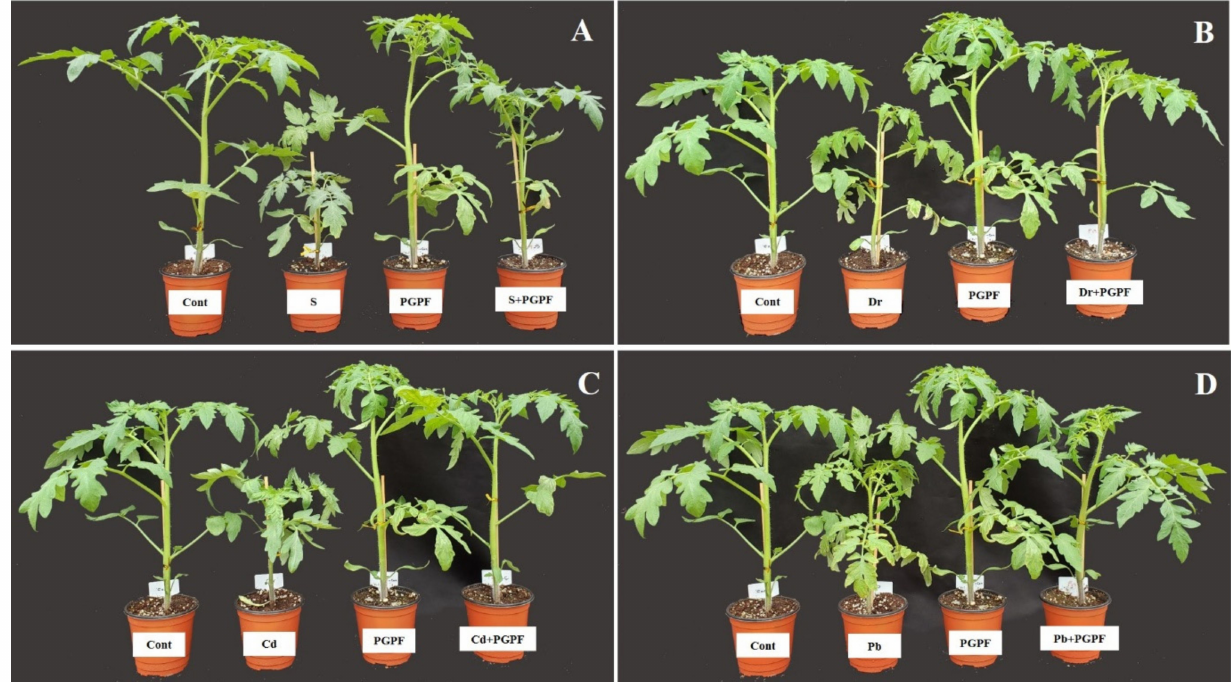
Figure 2. Effects of PGPF inoculation on tomato plant growth under normal and stress conditions after 10 days of treatment ( A – D ). Treatments: Cont (control), PGPF ( Cunninghamella bertholletiae ), S (1.5% sodium chloride), S (1.5% sodium chloride) + PGPF ( Cunninghamella bertholletiae ), Dr (25% polyethylene glycol), Dr (25% polyethylene glycol) + PGPF ( Cunninghamella bertholletiae ), Cd (3 mM lead) + PGPF ( Cunninghamella bertholletiae